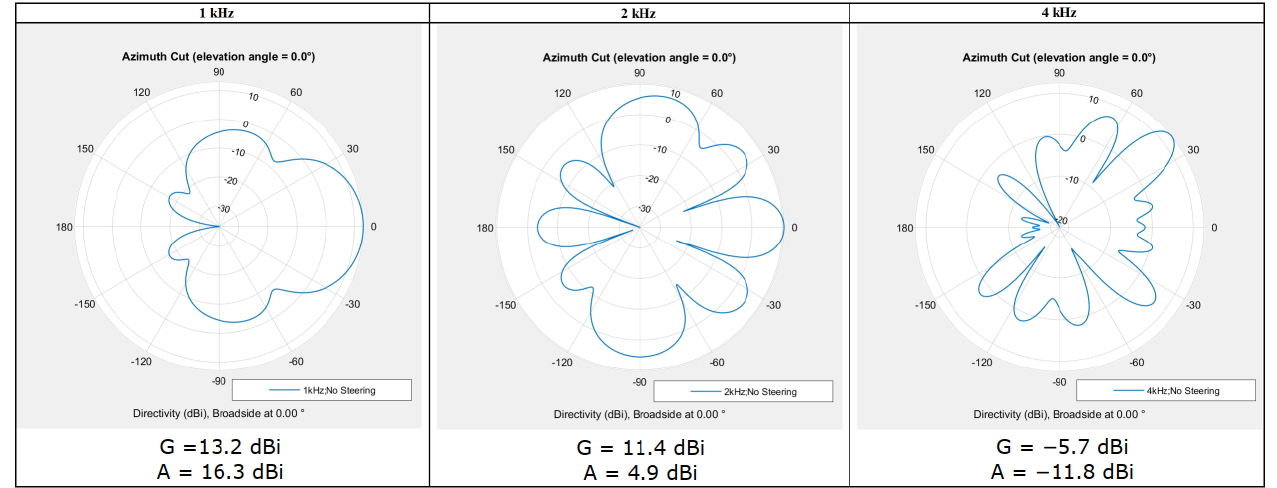
Figure 3. Directional characteristics for 1, 2 and 4 kHz (optimization carried out for f = 1 kHz) .